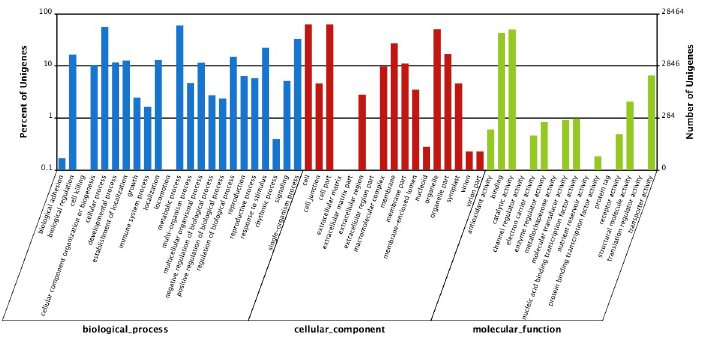
Fig 2. GO classification for A . emeiensis . by BLASTx with an E value threshold of 10 − 5 against the Nr